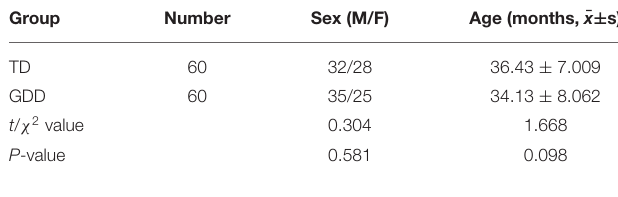
TABLE 1 | General information of TD and GDD.